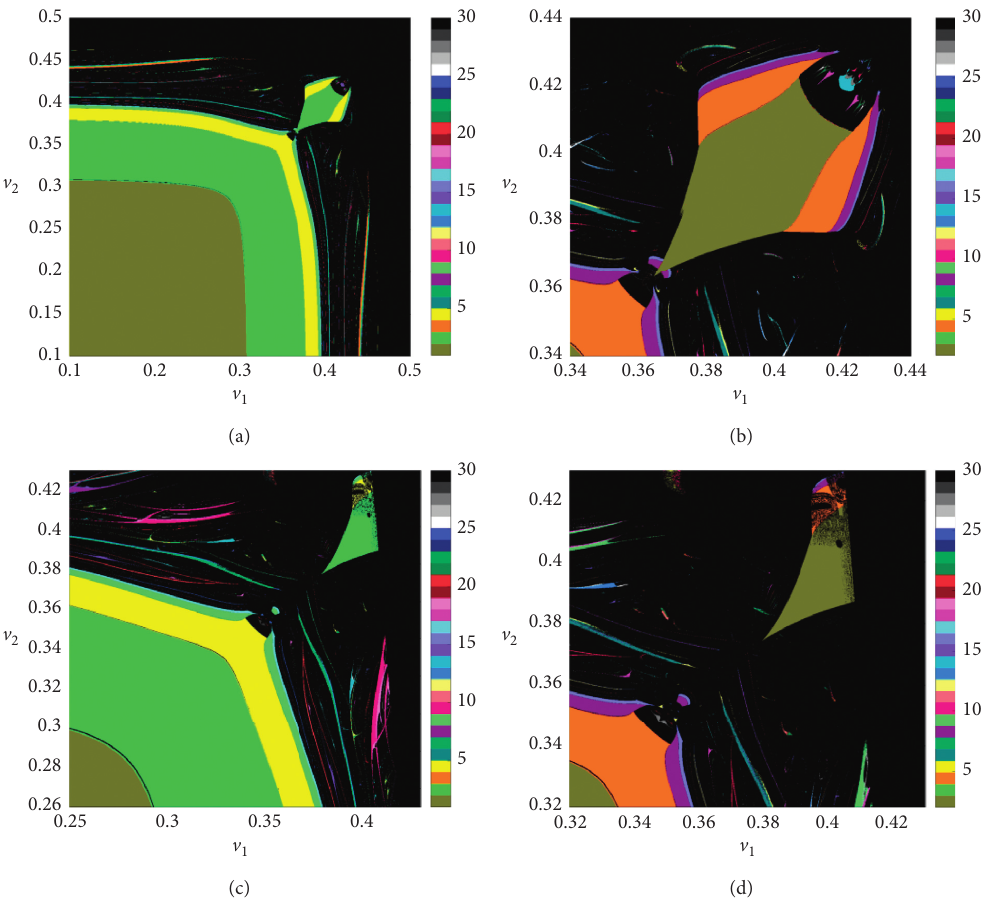
Figure 2: The 2-D bifurcation diagrams about v � 0 . 677, and α � 0 . 583; (b) partial enlargement of Figure 2(a); (c) a � 7 . 212, b � 0 . 28, c � 1 . 1, α α 1 2 enlargement of Figure